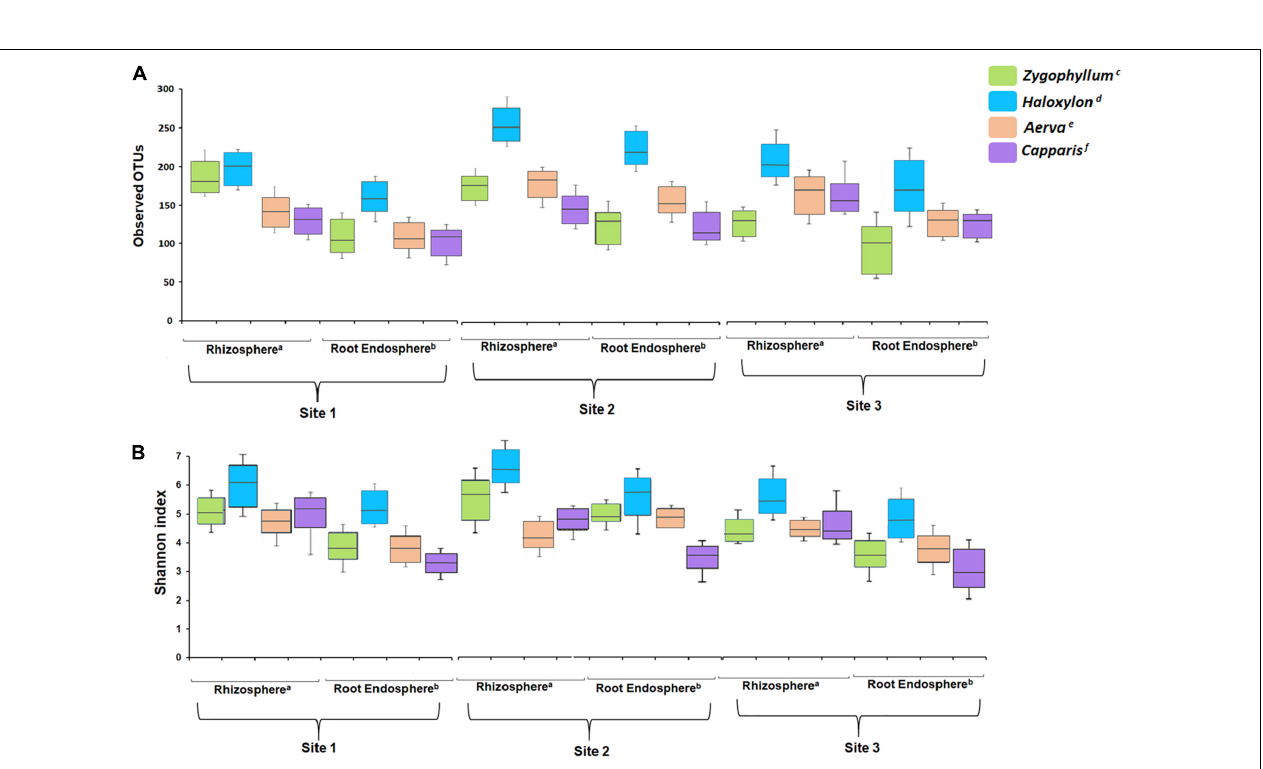
FIGURE 2 | Alpha diversity analysis. (A) Number of observed OTUs and (B) Shannon index. All the soil and root samples showed significant difference after a Kruskal–Wallis test with a confidence level of 99% ( p ≤ 0.05) in each index. Superscripts (a and b) indicate significant differences in the rhizosphere and root endosphere among plant species, while superscripts (c–f) indicate significant differences between sample types associated with a plant species.